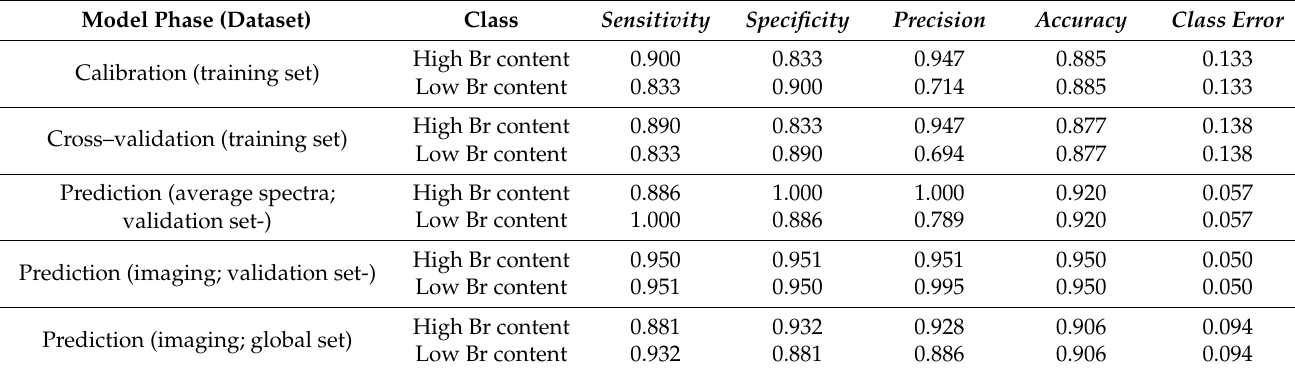
Table 5. Classification performance metrics for bromine content using SisuCHEMA XL™ data (average spectra and hyperspectral